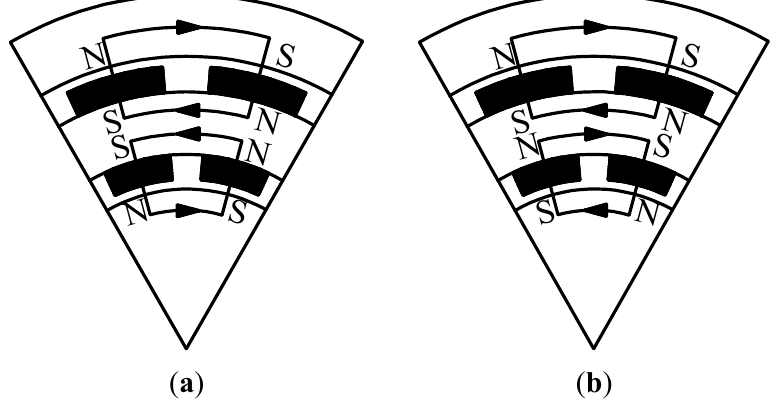
Figure 2. Schematic diagram of magnetic flux path when the inside and outside permanent magnets have opposite or consistent magnetization direction. ( a ) Opposite magnetization direction. ( b ) Consistent magnetization